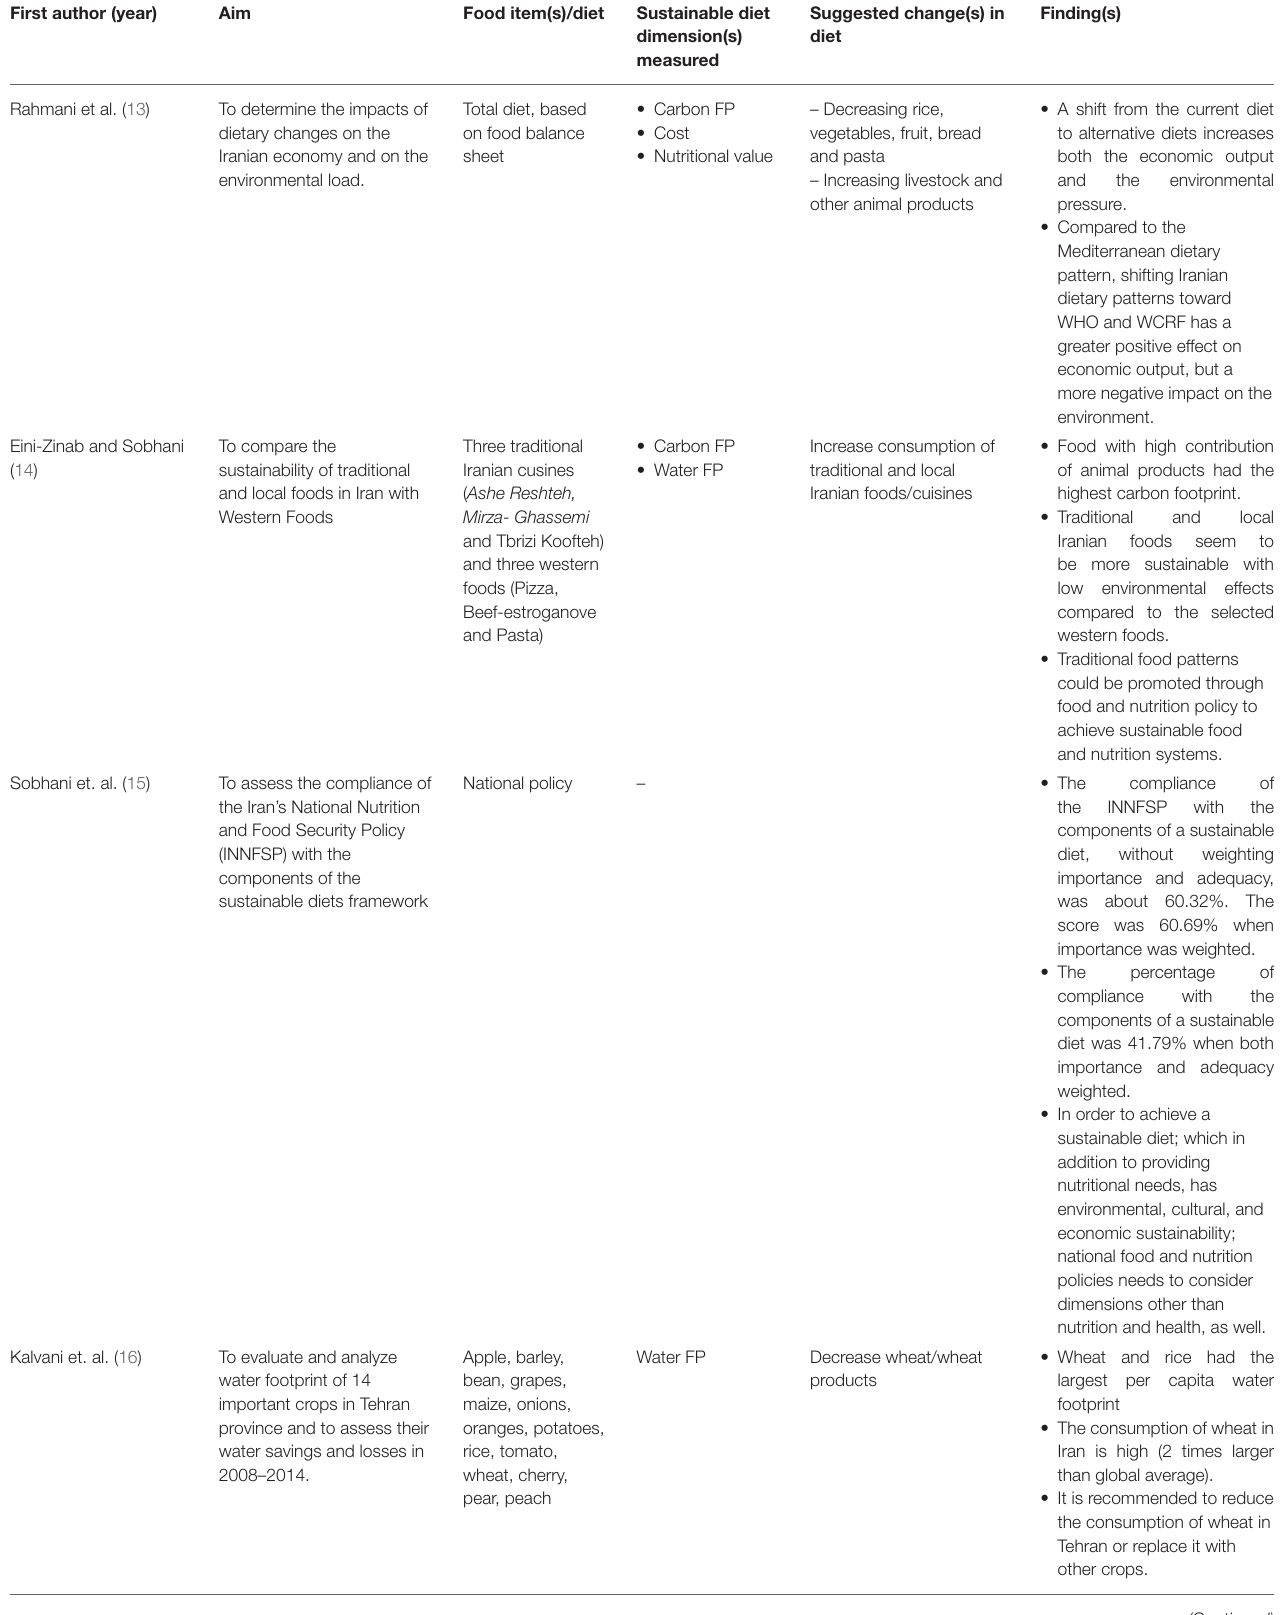
TABLE 1 | Summary of characteristics of studies on sustainable diet in Iran